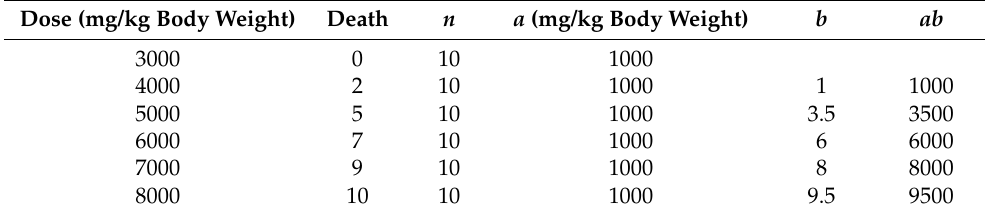
Table 3. Test data for determination of LD 50 values for penicillin IVc ( n —number of mice in each group, a —difference between two consecutive doses, and b —average value of the deaths from two consecutive doses).